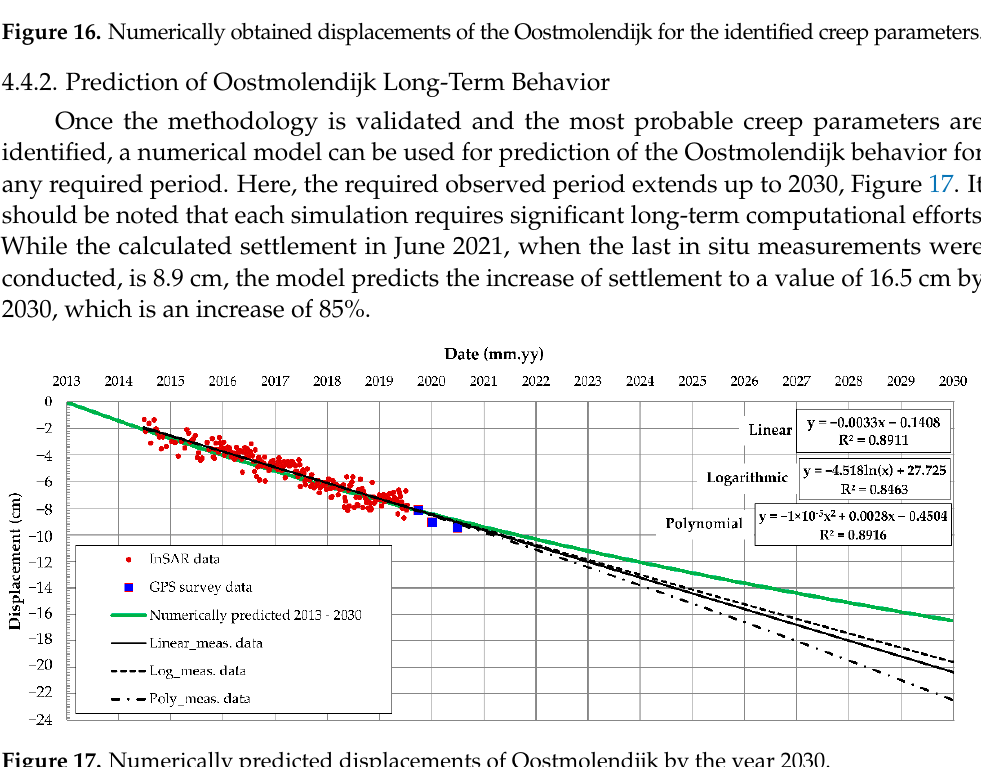
Figure 17. Numerically predicted displacements of Oostmolendijk by the year 2030.